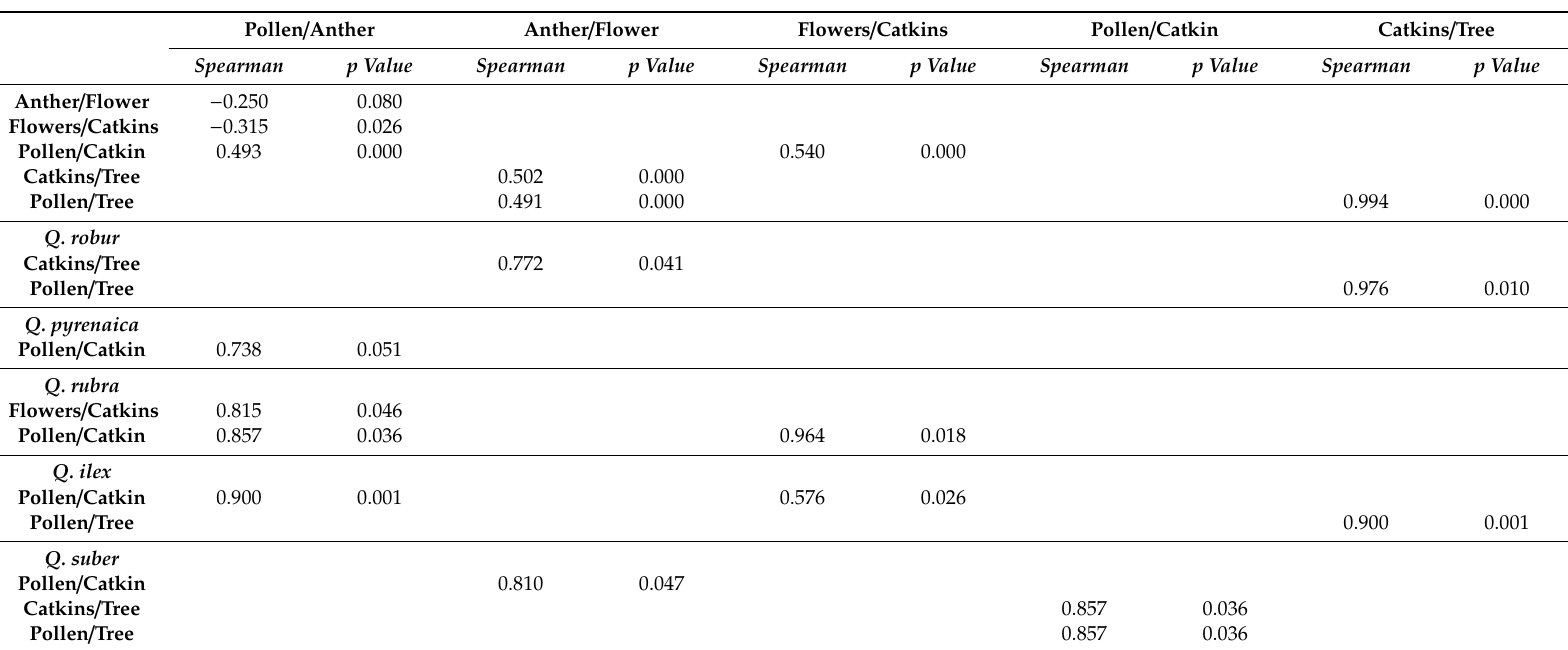
Table 2. Spearman’s correlation coe ffi cients between pollen per anther, anthers per flower, flowers per catkin, pollen per catkin, catkins per tree and pollen per tree considering the oak species and the data altogether. Not significant correlations were observed for Q. faginea